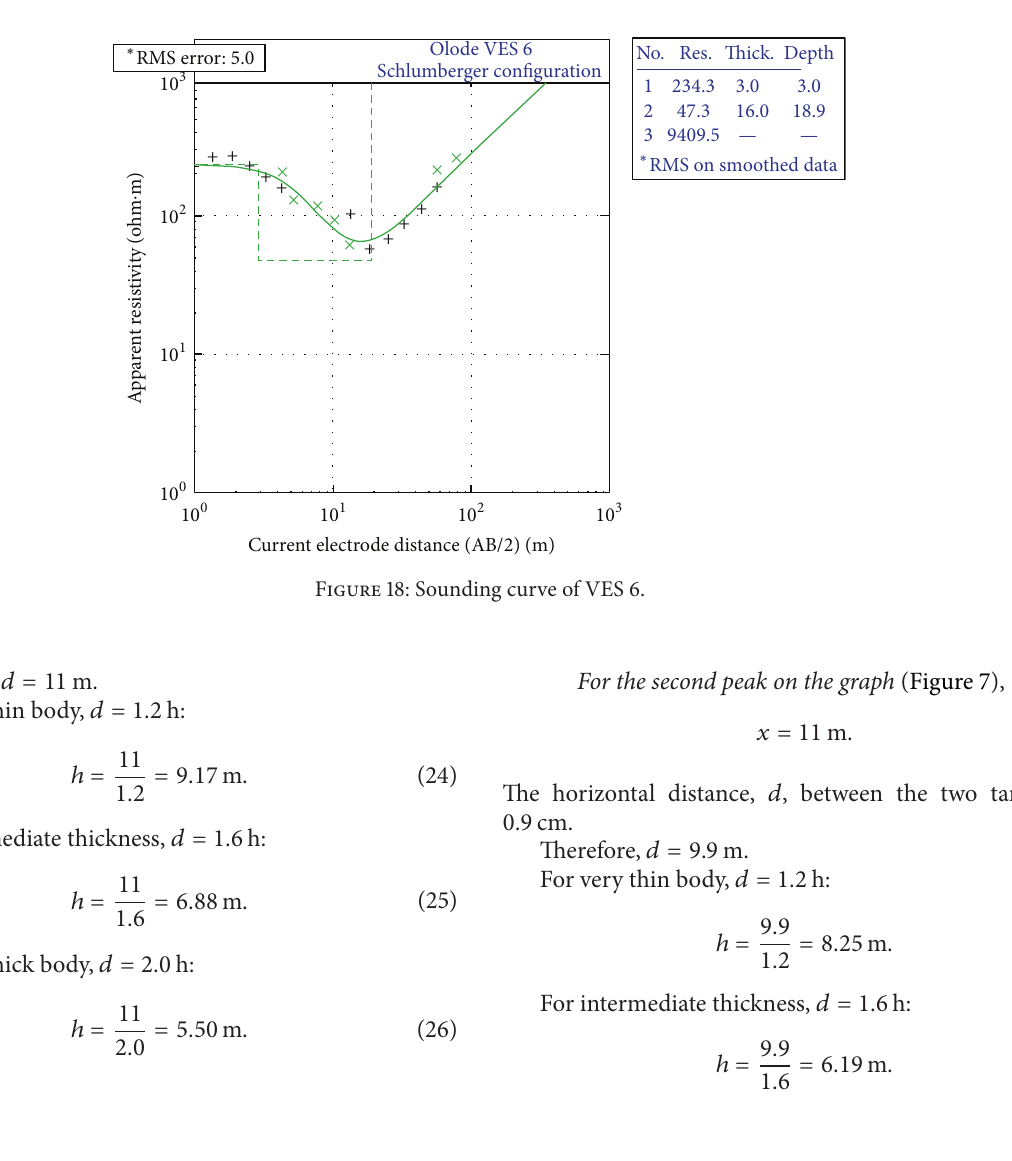
Figure 17: Sounding curve of VES 5.